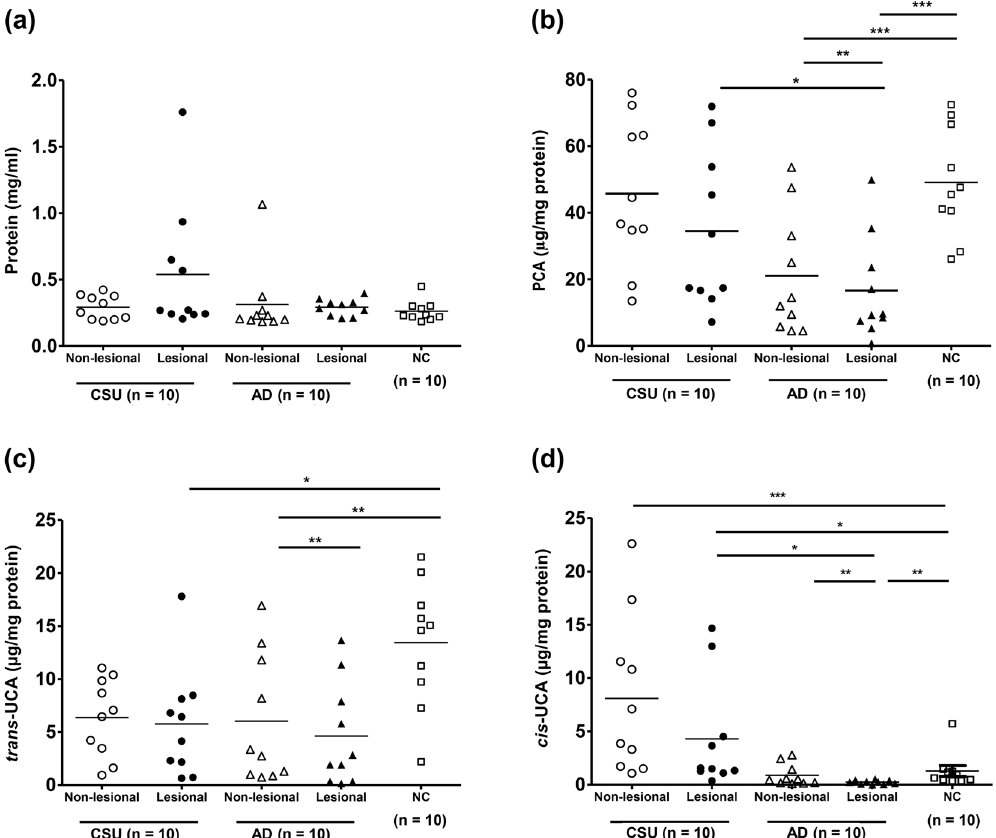
Figure 1. Concentrations of total protein ( a ) and filaggrin break down products, including PCA ( b ), trans- UCA ( c ), and cis- UCA ( d ), normalised to the quantity of protein from tape-stripped epidermal samples from study subjects. Horizontal lines in the middle of the dot plots indicate mean values. AD, atopic dermatitis; CSU, chronic spontaneous urticaria; Histamine, histamine-induced wheals; NC, normal control. * , ** , *** P < 0.05, 0.01, 0.001, obtained by one-way ANOVA with Bonferroni’s post-hoc test.